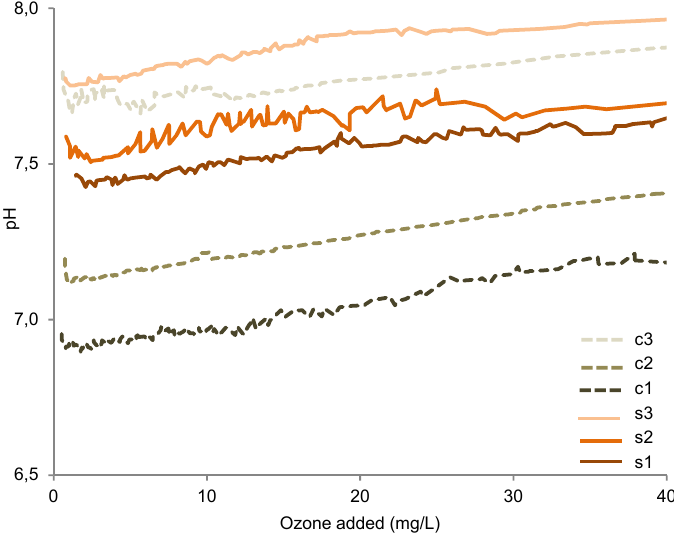
Figure 6. The pH increase as a function of ozone addition. Average trendline of the replicates for the individual